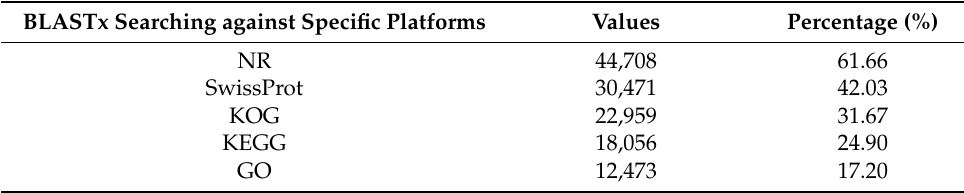
Table 2. Database searches for collected A. sinensis nucleotide